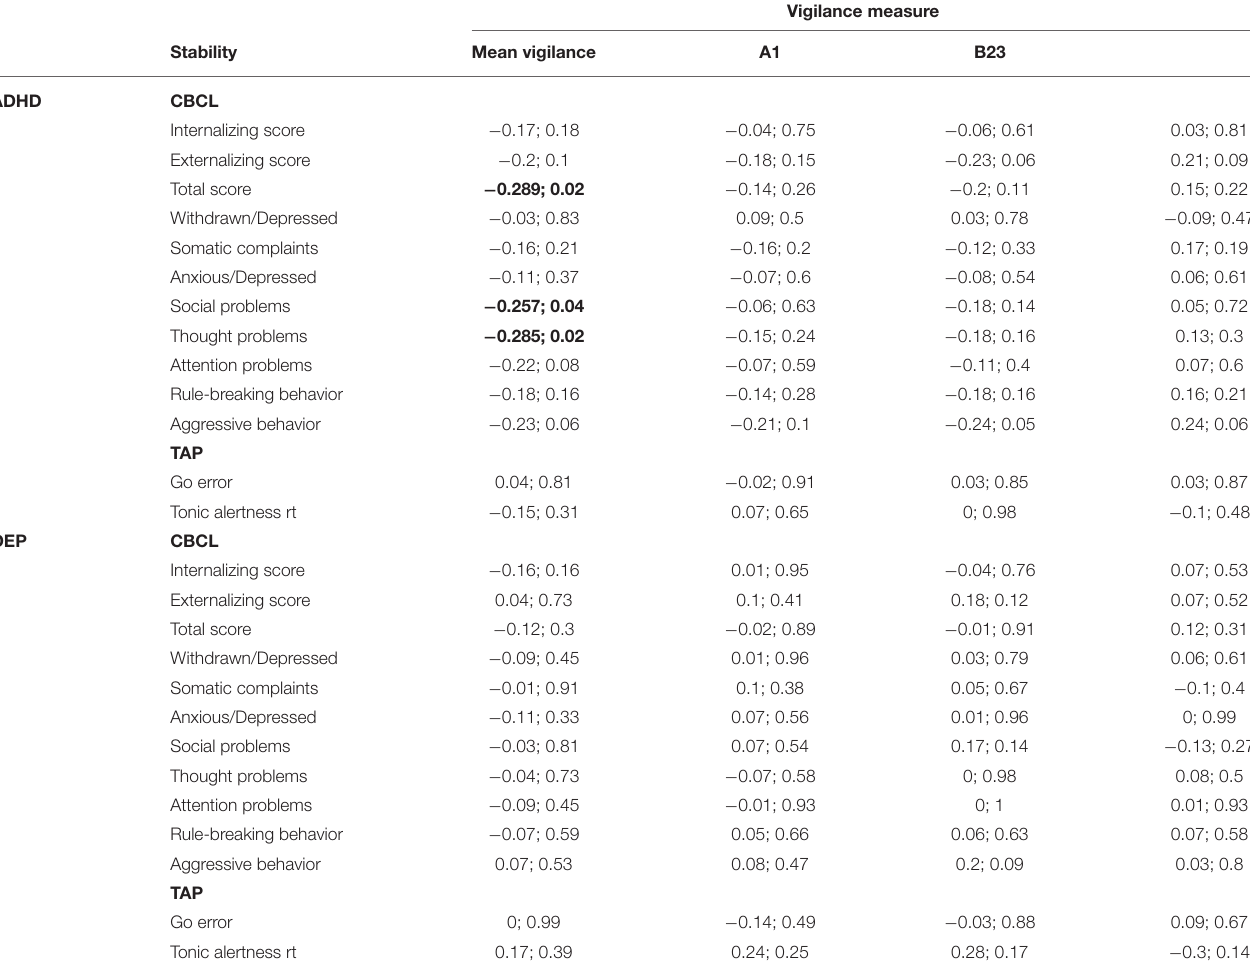
TABLE 5 | Correlation statistics of problematic behavior, attentional performance, and EEG vigilance.